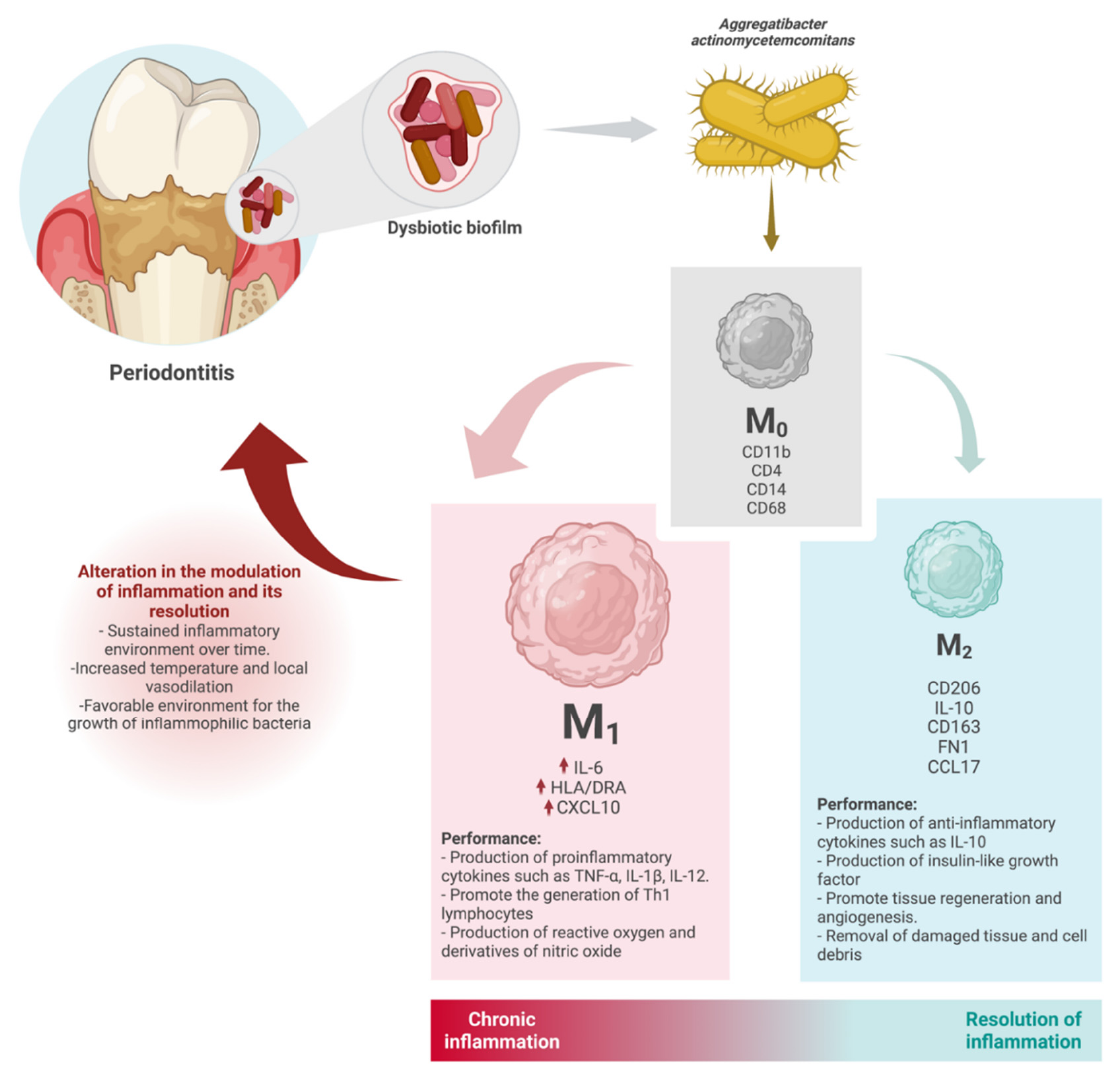
Figure 4. Macrophage polarization towards an M1 phenotype over an M2 phenotype, induced by Aggregatibacter actinomycetemcomitans , with increased gene expression of markers such as IL-6, HLA/DRA, and CXCL (characteristic of M1 populations), being one of the possible pathways of dysregulation of inflammation, preventing its resolution and contributing to an environment that favors bacterial dysbiosis in the periodontal